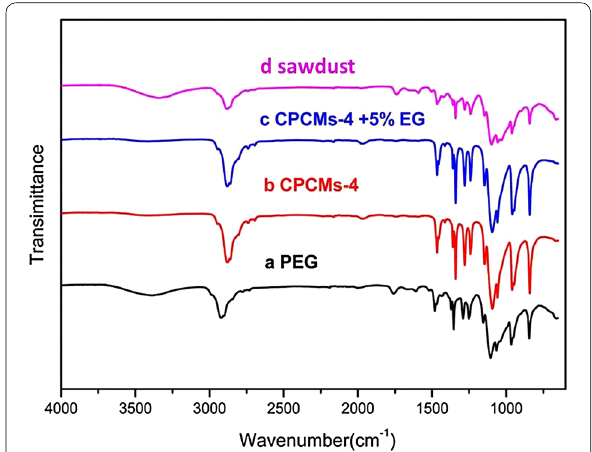
Fig. 3 XRD patterns for (a) EG, (b) PEG, (c) CPCMs‑4 with 5% EG, (d) CPCMs‑4, and (e) waste